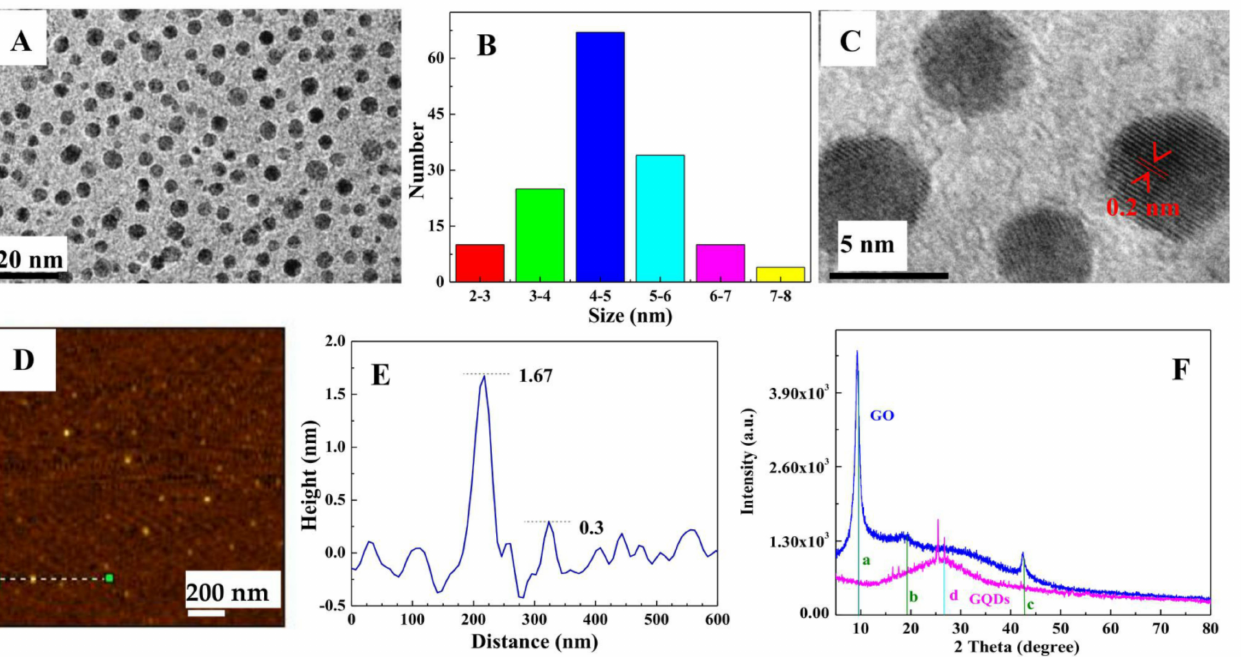
Figure 2. Morphology and structure of the graphene quantum dots (GQDs). ( A ) TEM, ( B ) size distribution, ( C ) HRTEM, ( D ) AFM, ( E ) the height profile corresponding to the line in ( D ), and ( F ) XRD patterns of GQDs and